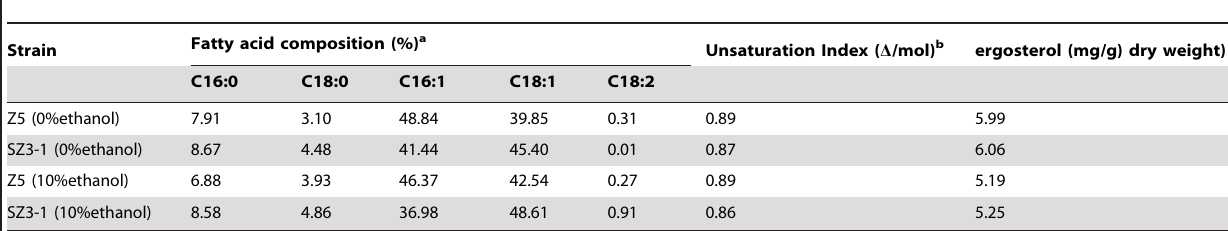
Table 2. Fatty acid compositions in plasma membrane and ergosterol content of strains Z5 and SZ3-1 cultivated in different